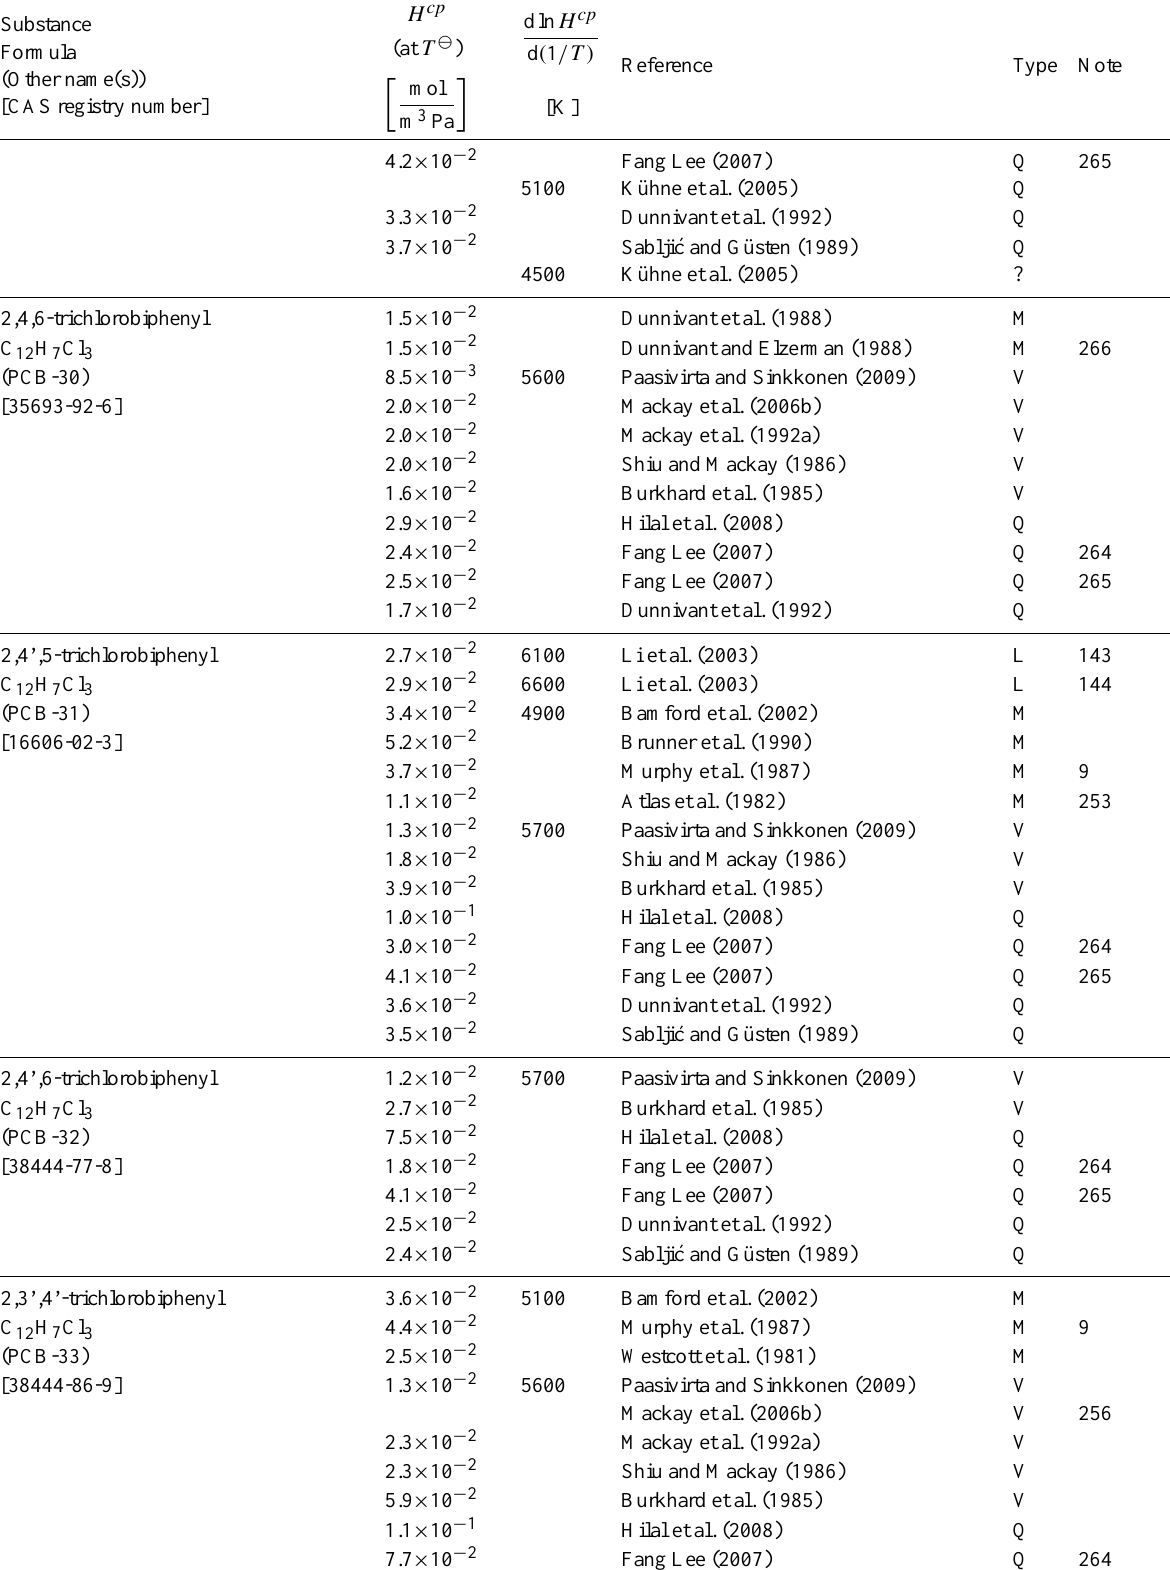
Table 6: Henry’s law constants for water as solvent